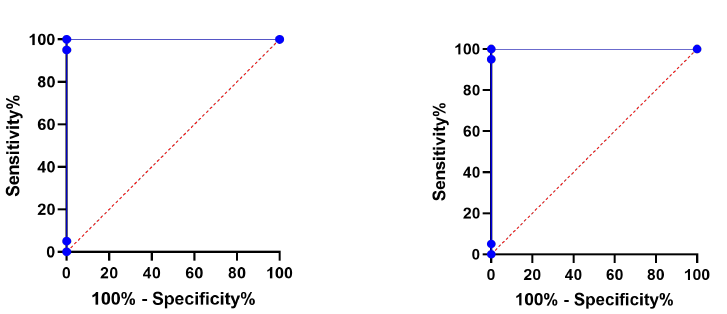
Figure 10. ROC curve for the presented GSDTO with PSO and WOA algorithms based LSTM model. The residual, QQ, homoscedasticity plots, and heat map of the presented and com- pared algorithms based on the LSTM model are shown in Figure 11. The residual plot places the independent variable on the horizontal axis and the residual values on the vertical axis. The residual plot is displayed in Figure 11. The homogeneity of variance or heteroscedasticity is visually inspected together with the projected scores for the dependent variable and can identify any violation. The accuracy of the research findings is increased by the heteroscedasticity plot, which is depicted in Figure 11. In Figure 11, the QQ plot is displayed, and it is used to compare two probability distributions by graphing the quantiles against one another. The point distributions in the QQ plot may be seen to roughly fit on the line in the figure. As a result, the relationship between the actual and anticipated residuals is almost linear, supporting the effectiveness of the suggested approach. The provided and compared algorithms’ heat maps are displayed in Figure 11. A two-dimensional color scale’s intensity reveals an algorithm’s level of sophistication. These figures confirm the quality of the GSDTO+LSTM model as mentioned in Figure 3.